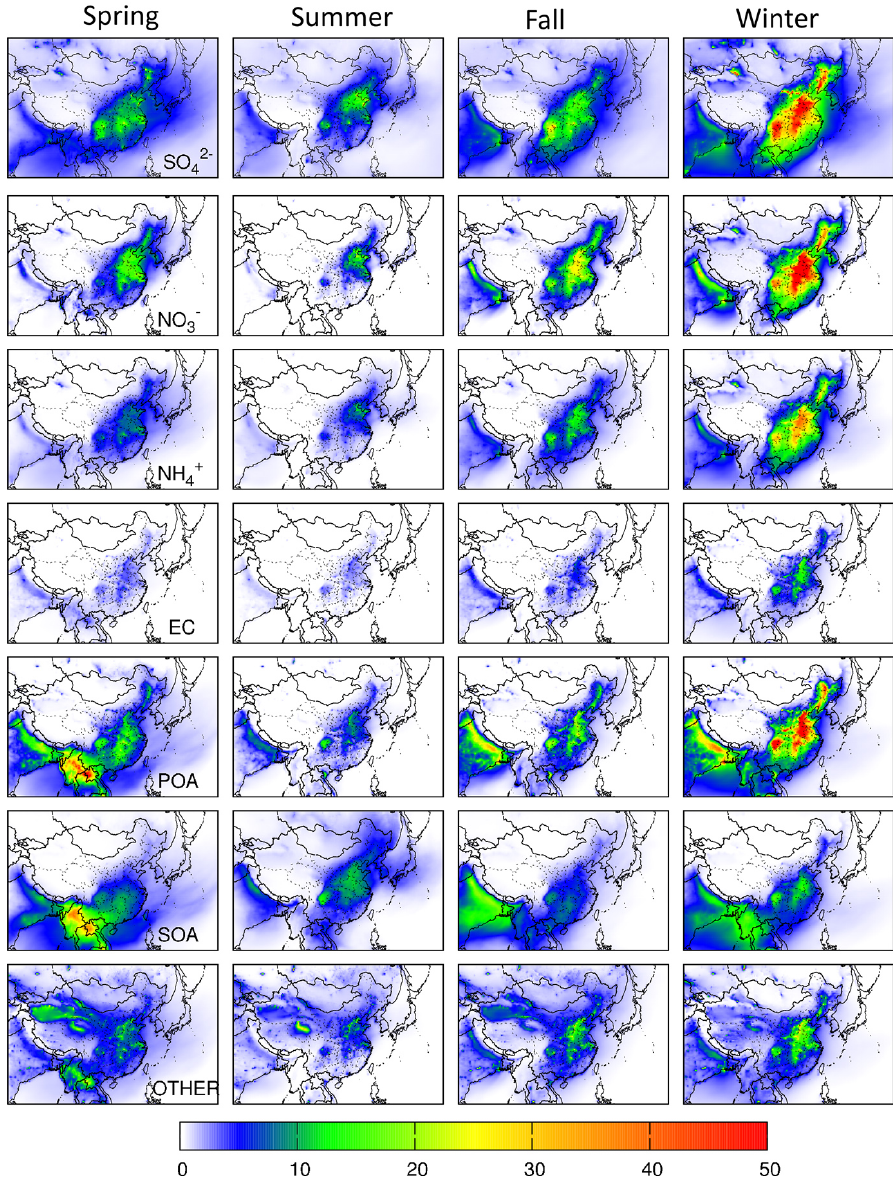
Figure 7. Seasonal variations of predicted PM 2 . 5 components. Units are µgm − 3